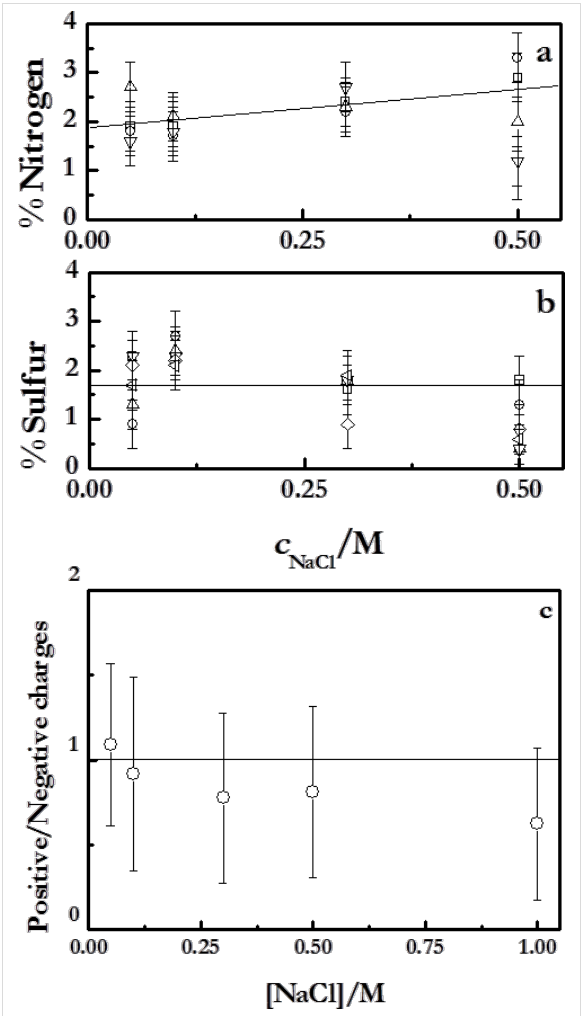
Figure 5: (a) Dependence on the salt concentration of the atomic frac- tion of nitrogen in (PDADMAC + PSS) N films, obtained by XPS mea- surement at different angles of electron emission: (squares) − 40°, (circles) − 30°, (upward triangles) − 20°, (downward triangles) − 10°, (diamonds) 0°, (leftward triangles) 10°. The solid lines are to guide the eye. (b) Dependence on the salt concentration of the atomic fraction of sulfur in (PDADMAC + PSS) N films, obtained by XPS measurement at different angles of electron emission: (squares) − 40°, (circles) − 30°, (upward triangles) − 20°, (downward triangles) − 10°, (diamonds) 0°, (leftward triangles) 10°. The solid lines are to guide the eye. (c): Dependence on the salt concentration for the ratio between posi- tive and negative charges in (PDADMAC + PSS) N films, obtained by XPS measurement at normal angle of incidence and 0° emission angle. The solid line is to guide the